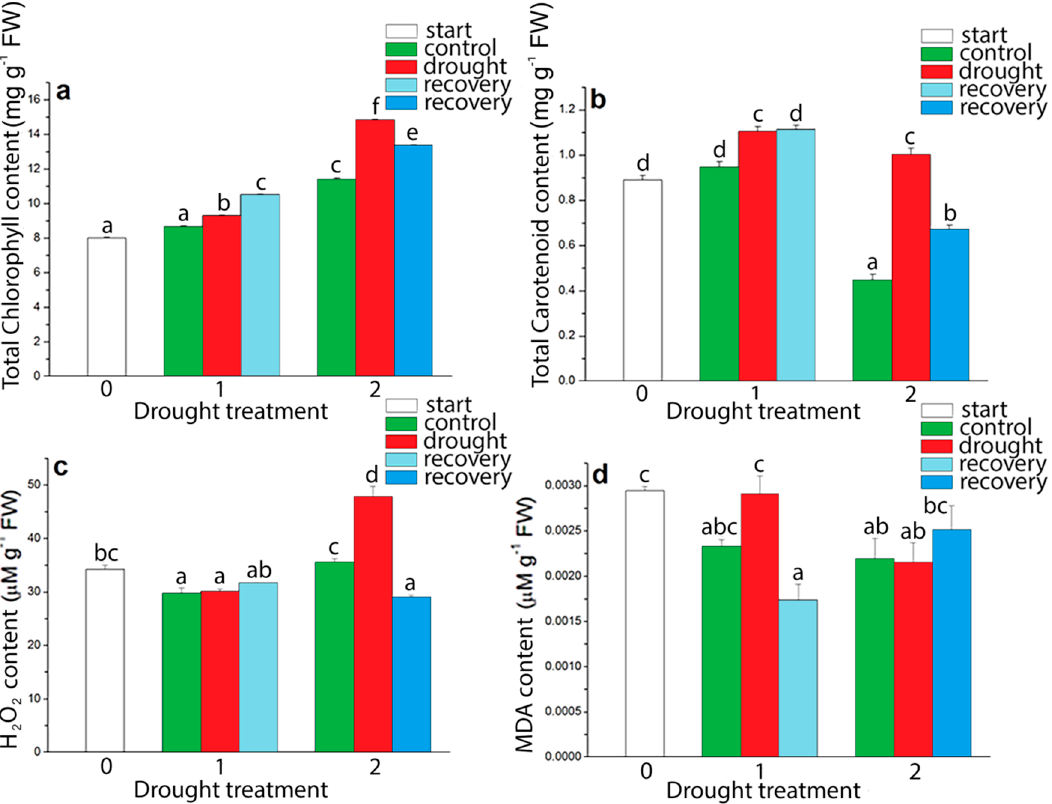
Figure 8. The effect of drought on total chlorophyll ( a ), total carotenoid ( b ), H 2 O 2 ( c ) and malondialdehyde (MDA) ( d ) content in I. walleriana grown ex vitro. The “start point”, 15% and 5% of soil moisture content—0, 1 and 2, respectively; results represent mean ± SE ( n = 8). The letters indicate statistically significant differences based on the Fischer LSD test ( p ≤ 0.05).